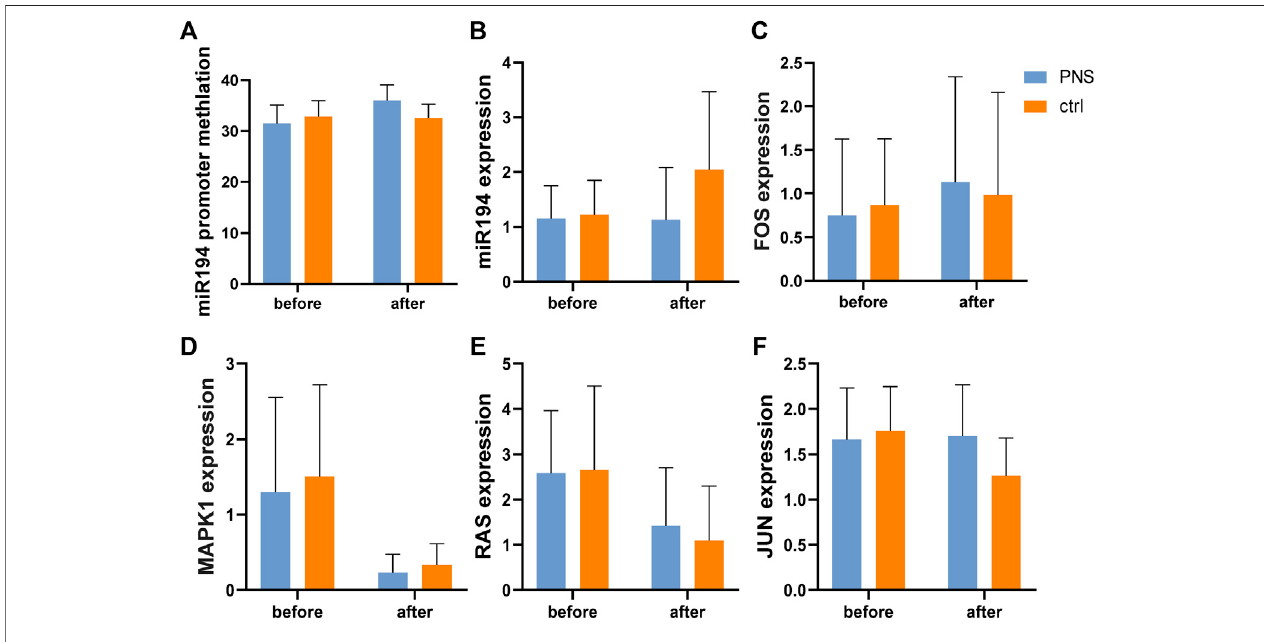
FIGURE 3 | Study participant fl ow diagram.